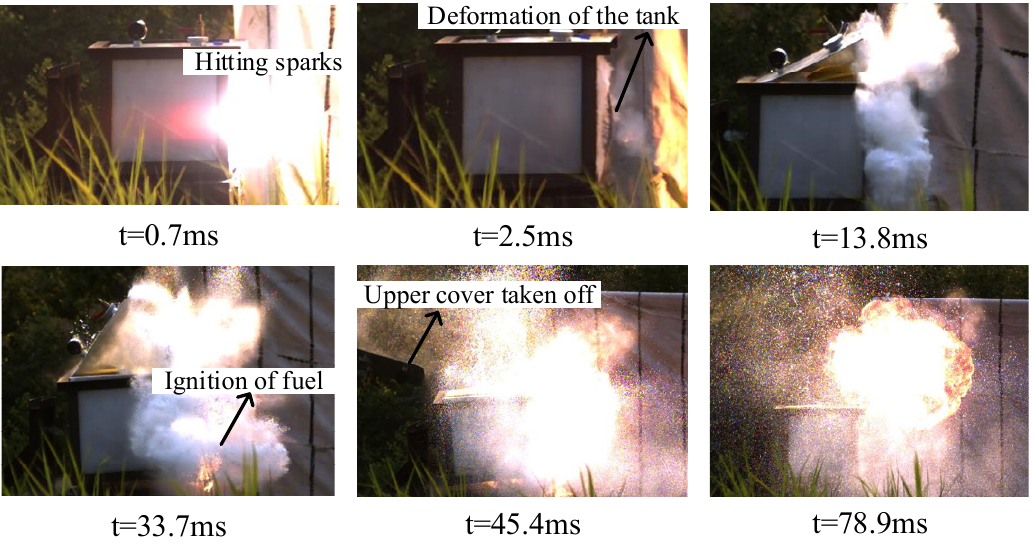
Figure 10. Destruction of the fuel tank by the 9 g energetic fragment (v = 1781 m/s).